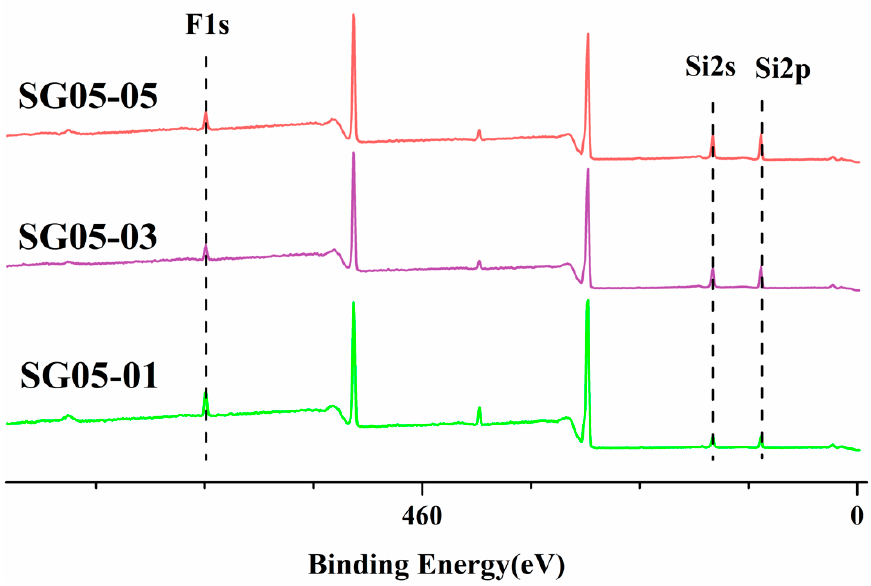
Figure 7. X-ray photoelectron spectroscopy (XPS) of the SG05 series resin at different low-surface energy masses: 0.1 g, 0.3 g, and 0.5 g, denoted by SG05-01, SG05-03, and SG05-05, respectively. Table 2. Comparison of theoretical and measured amounts of SG05 series.